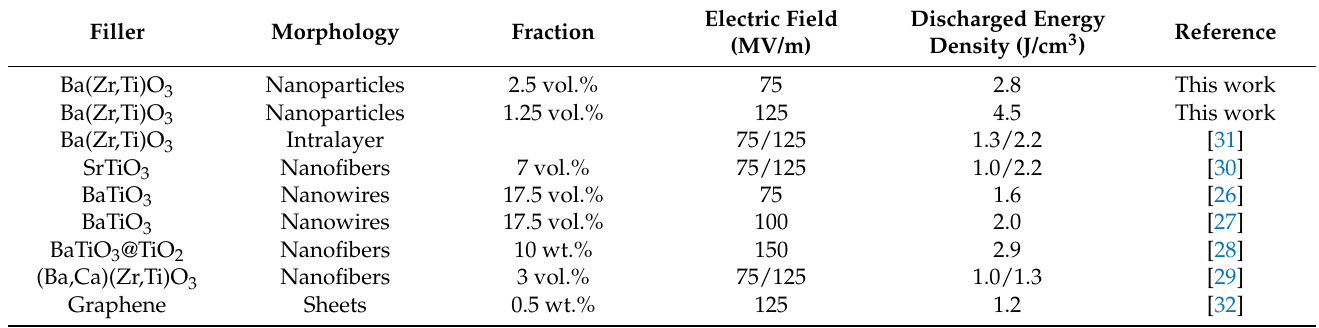
Comparison of discharge energy density in composites based on relaxor P(VDF- TrFE-CFE)